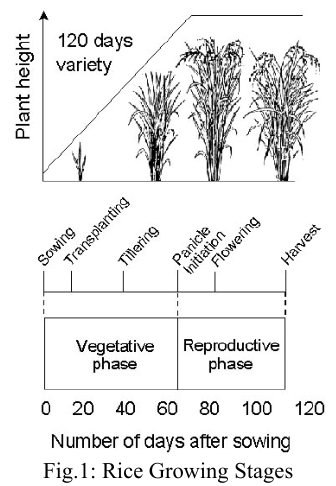
Fig.1: Rice Growing Stages